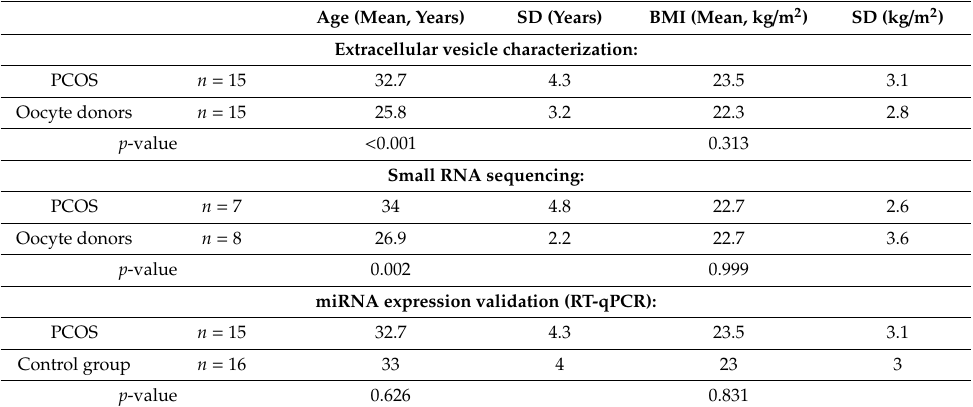
Table 1. General characteristics of study participants by used method.